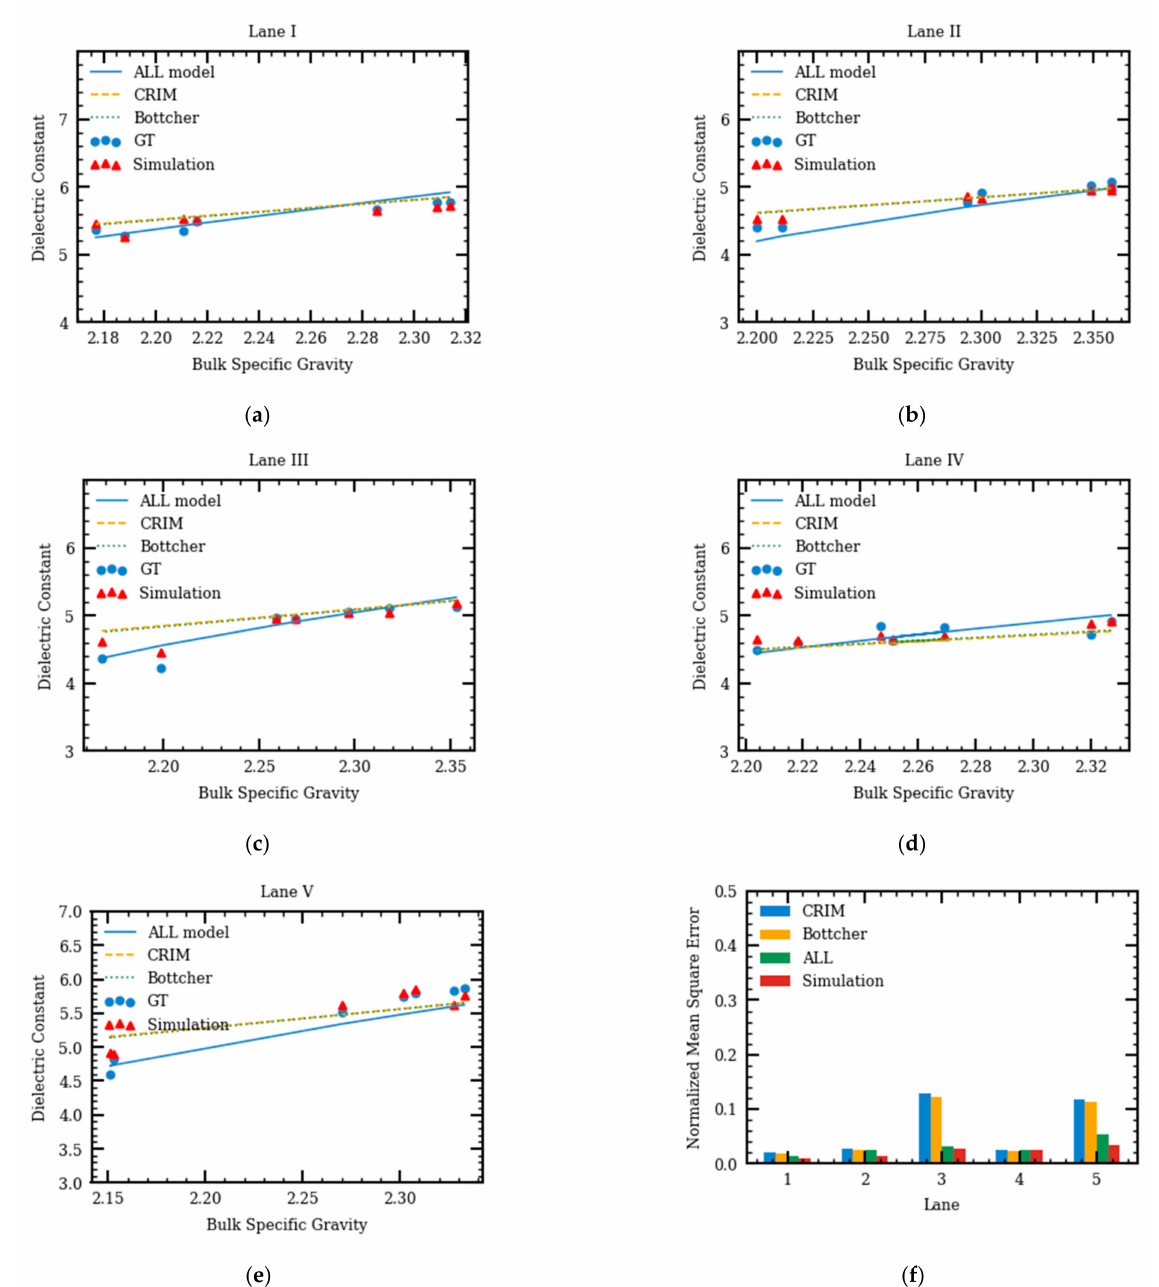
Figure 8. Comparison between ground truth (GT) and results from different models for lanes I–V ( a – e ) as well as the normalized mean square error of different models ( f